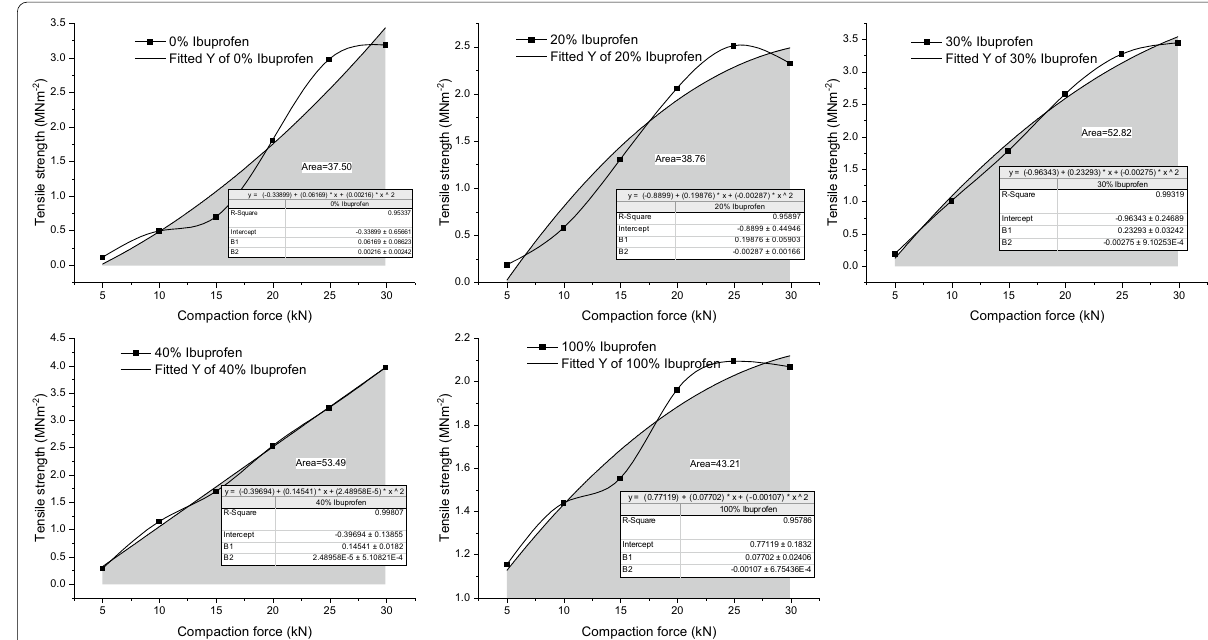
Fig. 6 Area under the tensile strength–compaction force curve for StarLac ® . Tensile strength computed according to the Shang et al. (2013) model